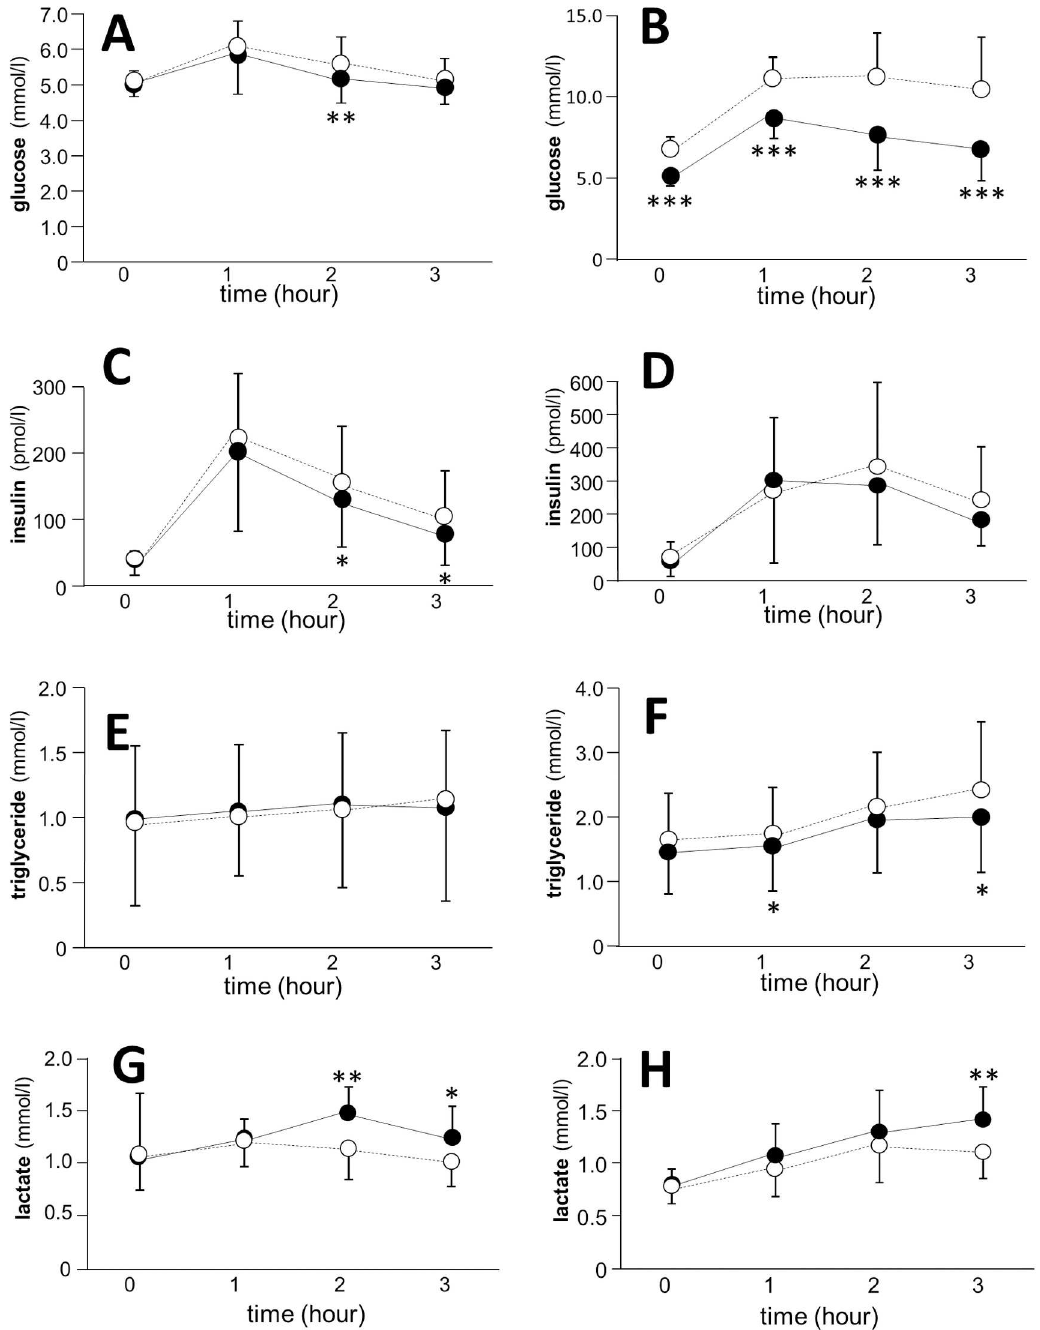
Fig 1. Effects of metformin on metabolic factors in healthy subjects (A, C, E, G) and diabetic patients (B, D, F, H). A, B; glucose,C, D; insulin,E, F; triglyceride, G, H; lactate. Data are presented as mean ± S.D. Paired t test was used for the comparisonbetweengroups. Open circle and dotted line; before metformin treatment, closed circle and solid line; after a 2-week treatment by metformin. * P < 0.05, ** P < 0.01, *** P < 0.001 vs. the value before metformin